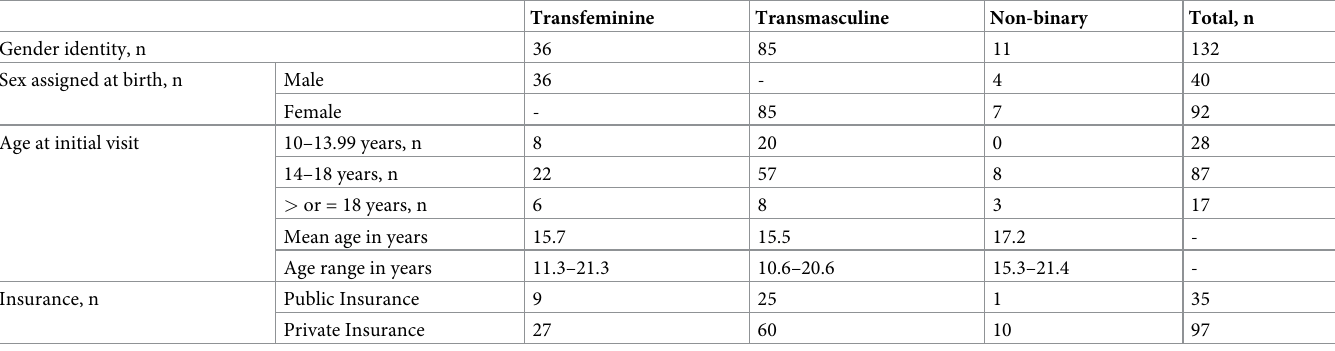
Table 1. Baseline characteristics and demographics.